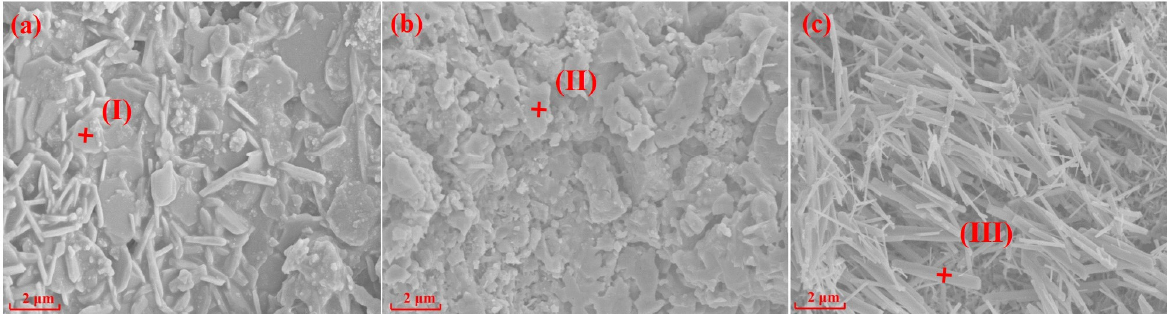
Figure 4. SEM and EDS of specimens with different silicon sources after sintering at 1200 °C: ( a ) Fly ash; ( b ) Silica dust; ( c ) Gangue.